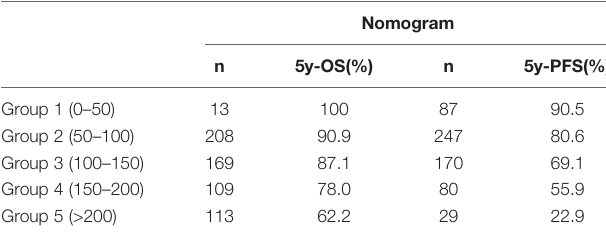
FIGURE 3 | Internal validation of the nomogram to predict overall survival (OS) and progression-free survival (PFS) likelihoods in patients with LACSC. The nomogram-predicted probability of OS and PFS is plotted on the x axis; the actual OS and PFS is plotted on the y axis. (A) calibration curve for 5-year OS; (B) calibration curve for 5-year PFS. TABLE 5 | Overall survival and progression-free survival according to nomogram score